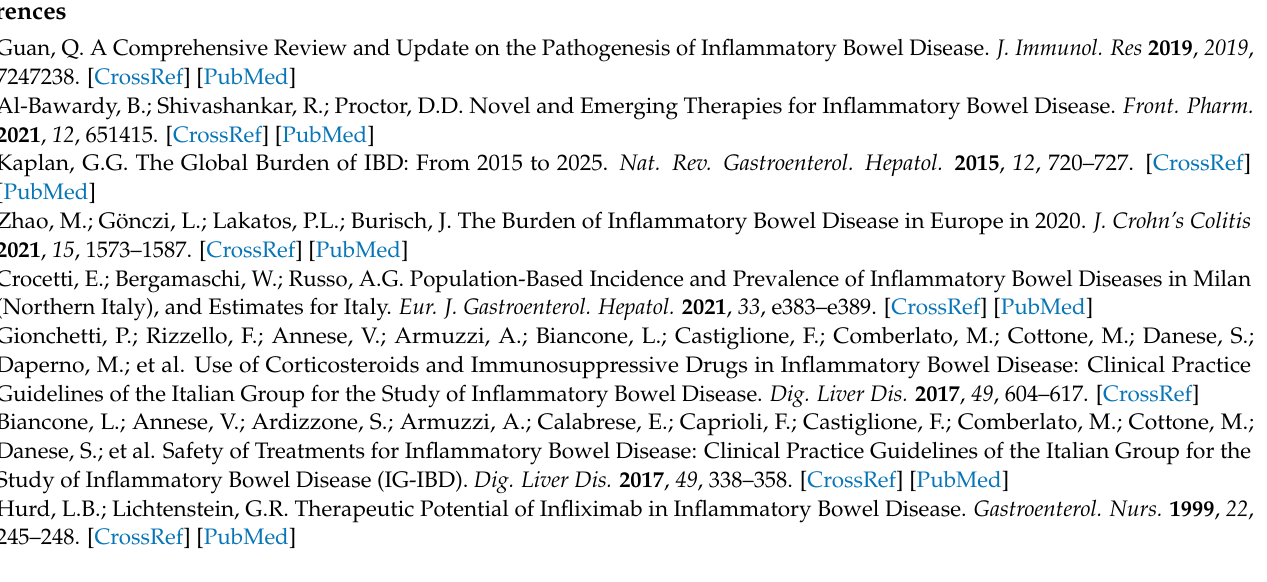
Figure S2: Kaplan–Meier curve for the persistence of biologics in patients with CD (a) and UC (b). Table S2: Type of adverse drug reactions observed during the follow-up period by therapy